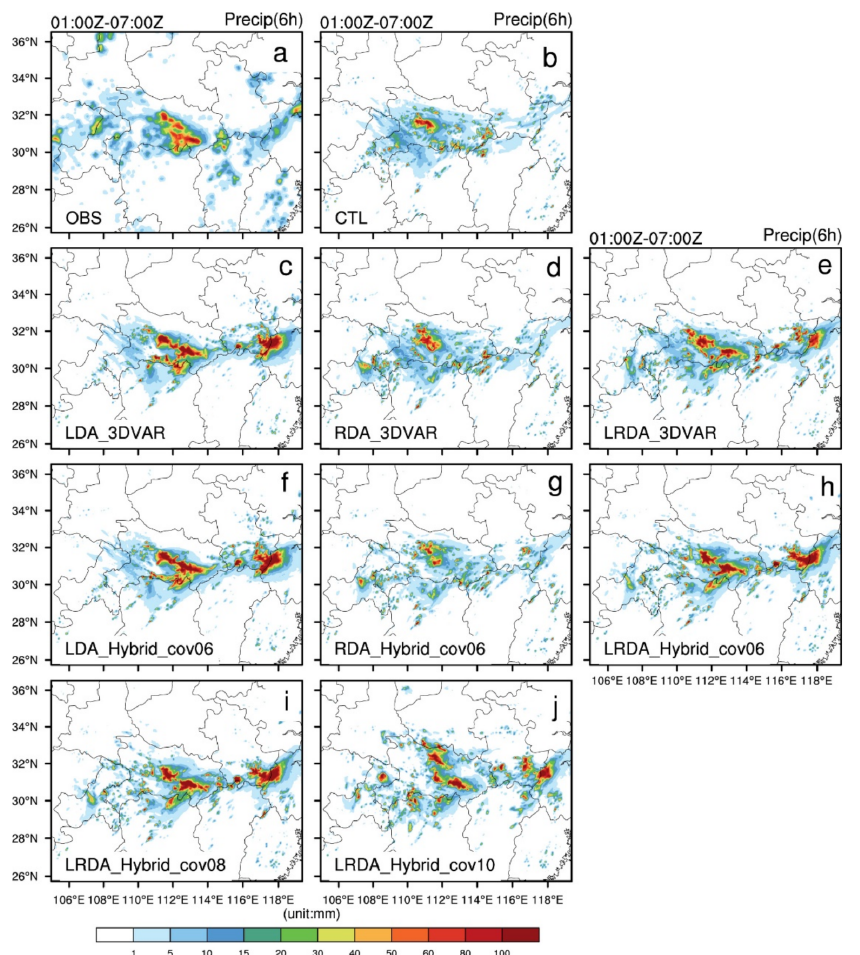
Figure 11. As in Figure 8, but for the cycling analysis experiments from 0100 UTC to 0700 UTC on 30 June 2018. ( a ) Observed precipitation (OBS), ( b ) control run (CTL), ( b ) control run (CTL), lightning ( c , f ), radar ( d , g ) and the combined lightning and radar data assimilation ( e , h ) by 3DVAR ( c – e ) and hybrid 3DEnVAR ( f – h ) showed that β 1 = 0.4, β 2 = 0.6. The combined lightning and radar data assimilation by hybrid 3DEnVAR ( i , j ) showed that β 1 = 0.2, β 2 = 0.8 and β 1 = 0.0, β 2 = 1.0,